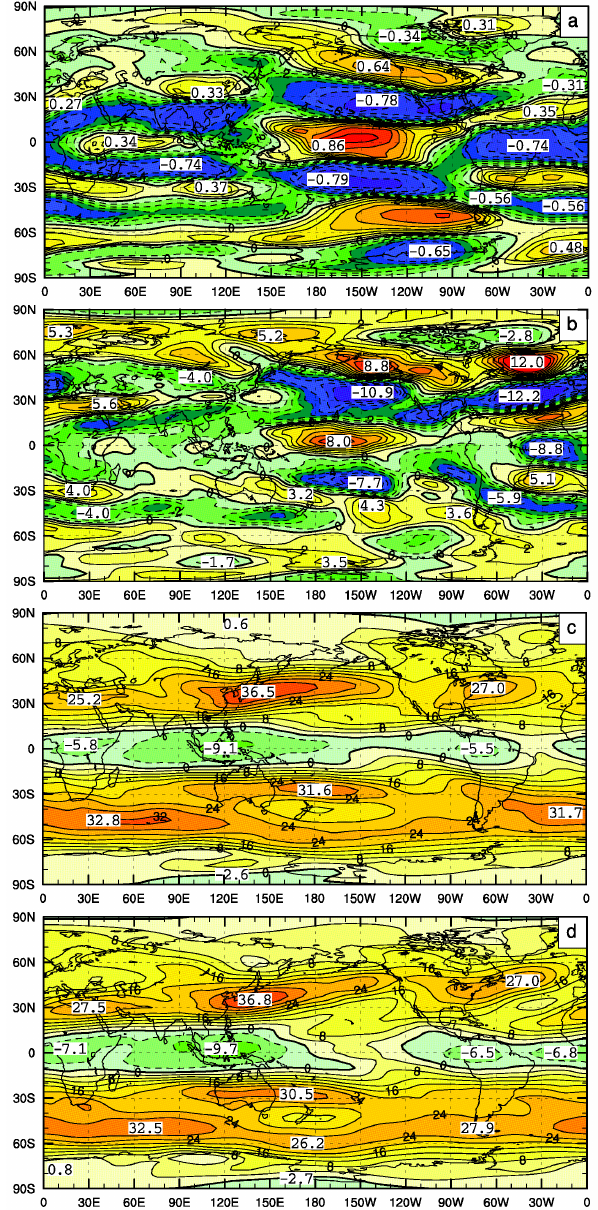
Figure 4. The equatorial upper-troposphere duct. Panel (a) : correla- tion over the annual cycle of 1949–2011 upper-tropospheric winds (300hPa) with the Southern Oscillation Index (SOI), with strongest correlation in the equatorial Pacific duct. Panel (b) : the difference between open and closed equatorial duct patterns of Fig. 4d and c, showing similarity to the long-term correlation pattern in Fig. 4a. Panel (c) : July 2009 to June 2010 “closed-duct” pattern with 300 hPa easterly zonal wind in the equatorial duct. Panel (d) : July 2008 to June 2009 “open-duct” pattern with 300 hPa westerly zonal winds in the equatorial